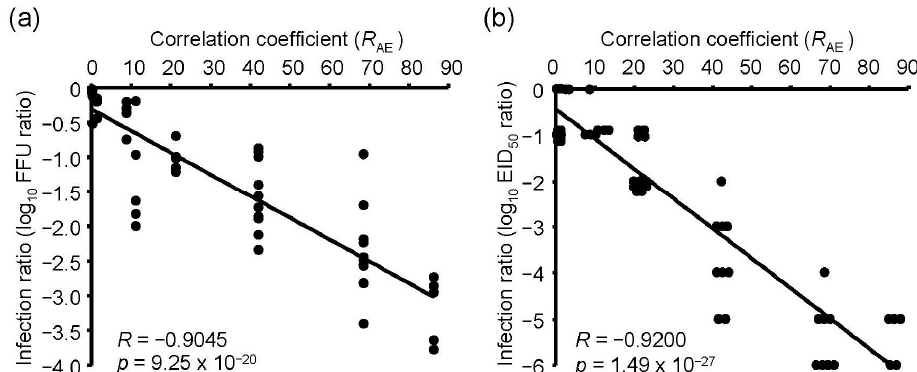
Figure 6. The relationship between the inactivation effects of UV irradiations and R AE scores. Inactivation effects were measured by infection into MDCK cells ( a ) or embryonated chicken eggs ( b ) as host organisms. R AE score indicates the correlation coefficient between the absorbance spectrum of viral RNA and emission spectrums of UV irradiations. Table 2. The Difference in Correlation Coefficients between the Disinfection Ratio and Peak Wavelength or R AE of UV Irradiations.